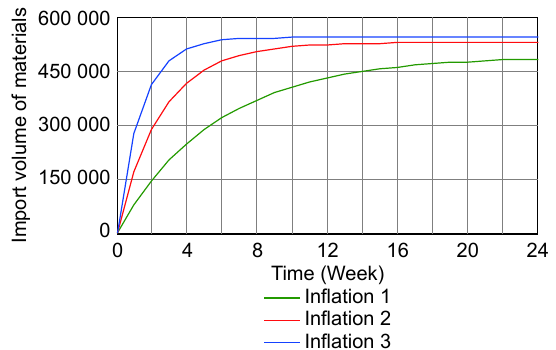
Fig. 11 Comparison of material imports under different inflation